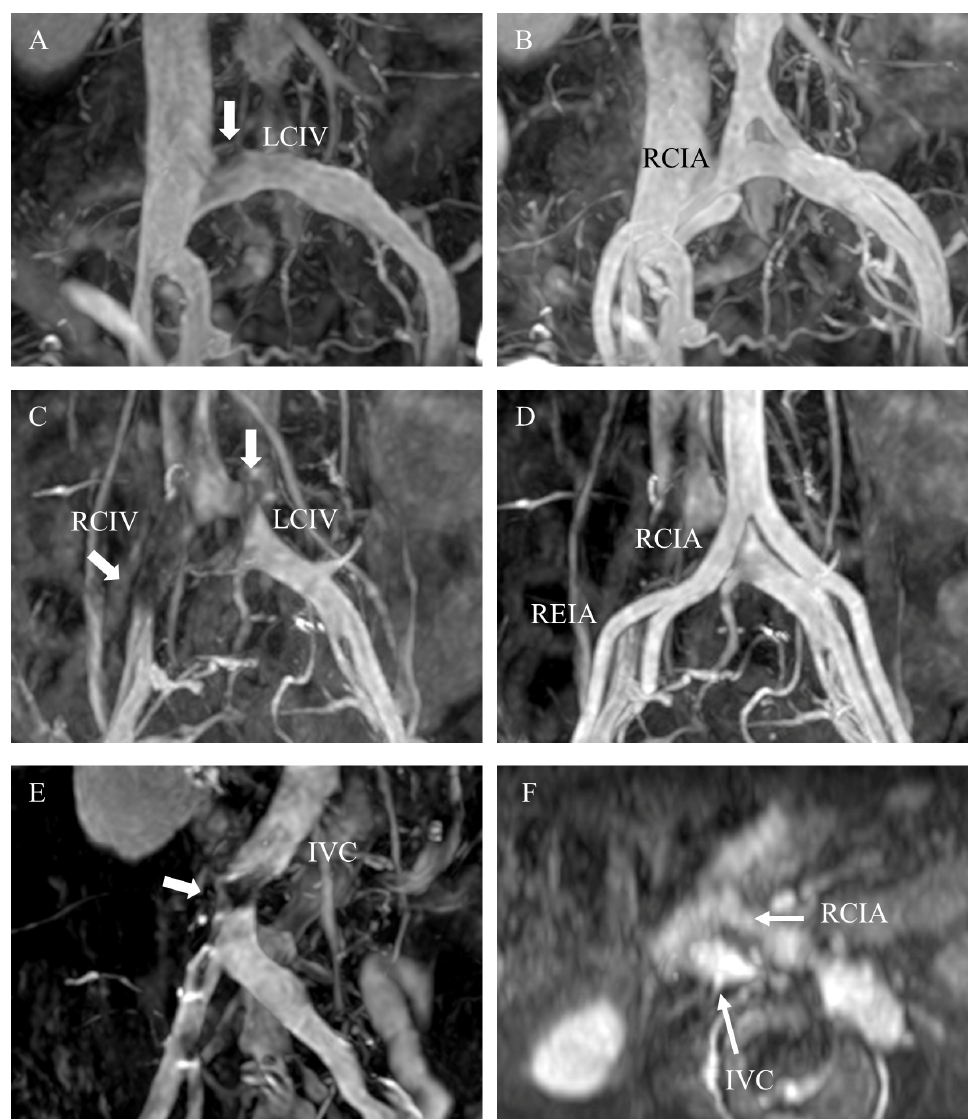
Figure 2. Examples of various venous indentations in triggered angiography non-contrast enhanced magnetic resonance imaging, including a left common iliac venous indentation (white arrow) ( A ) by the overlying right common iliac artery ( B ), bilateral common iliac venous indentations (white arrows) ( C ) by the right overlying right common and external iliac veins ( D ), and an inferior vena cava indentation (white arrow) ( E ) by the right common iliac artery ( F ). Abbreviations: IVC, inferior vena cava; LCIV, left common iliac vein; RCIA, right common iliac artery; RCIV, right common iliac vein; REIA, right external iliac